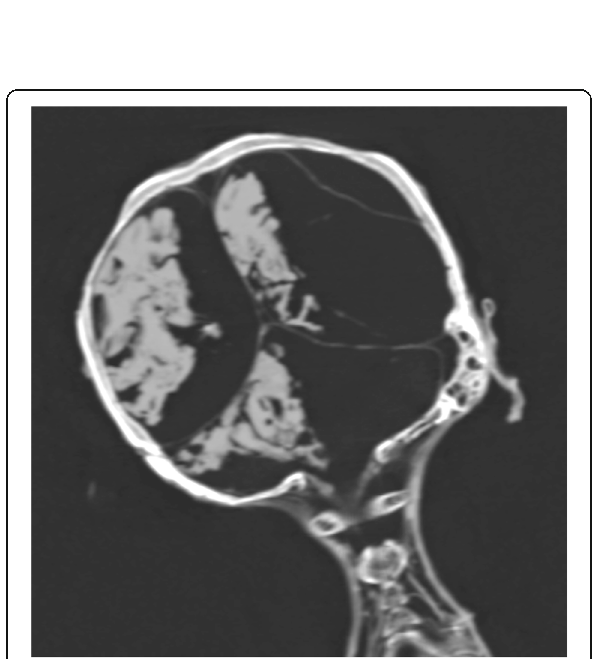
Fig. 4 Coronal CT image of the head and neck of mummy “ Unknown-Woman-A. ” The head is tilted to the right, and the desiccated brain is seen shifted to the right side of the cranial cavity. Teeth attrition could be seen through the gaping